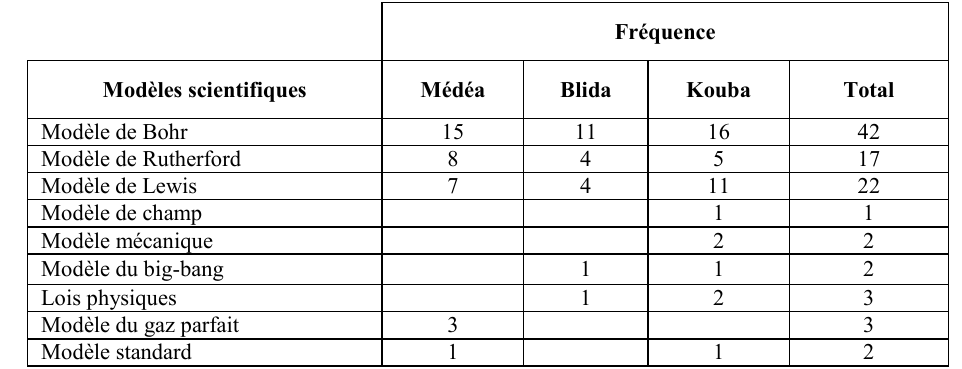
Table 3. Les modèles cités par les étudiants comme